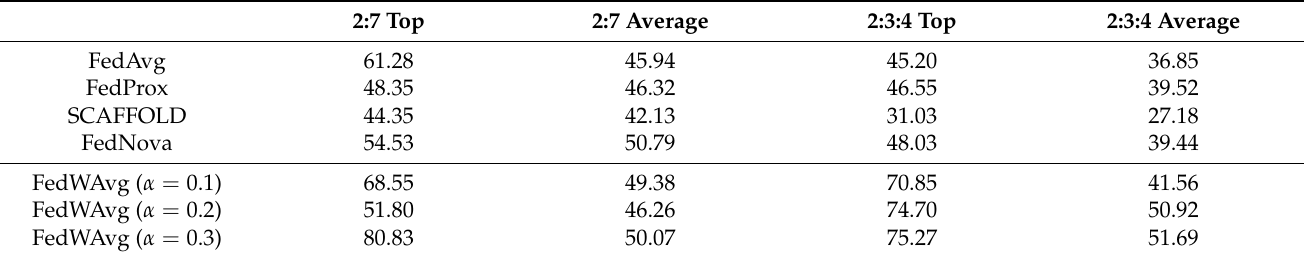
Table 5. Test accuracy (%) for